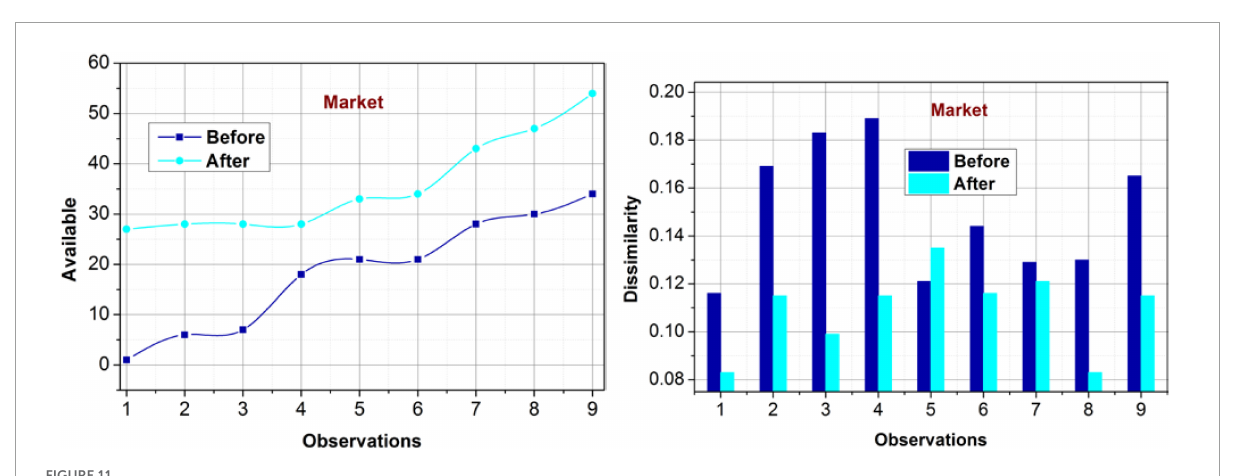
FIGURE11 Availability and dissimilarity